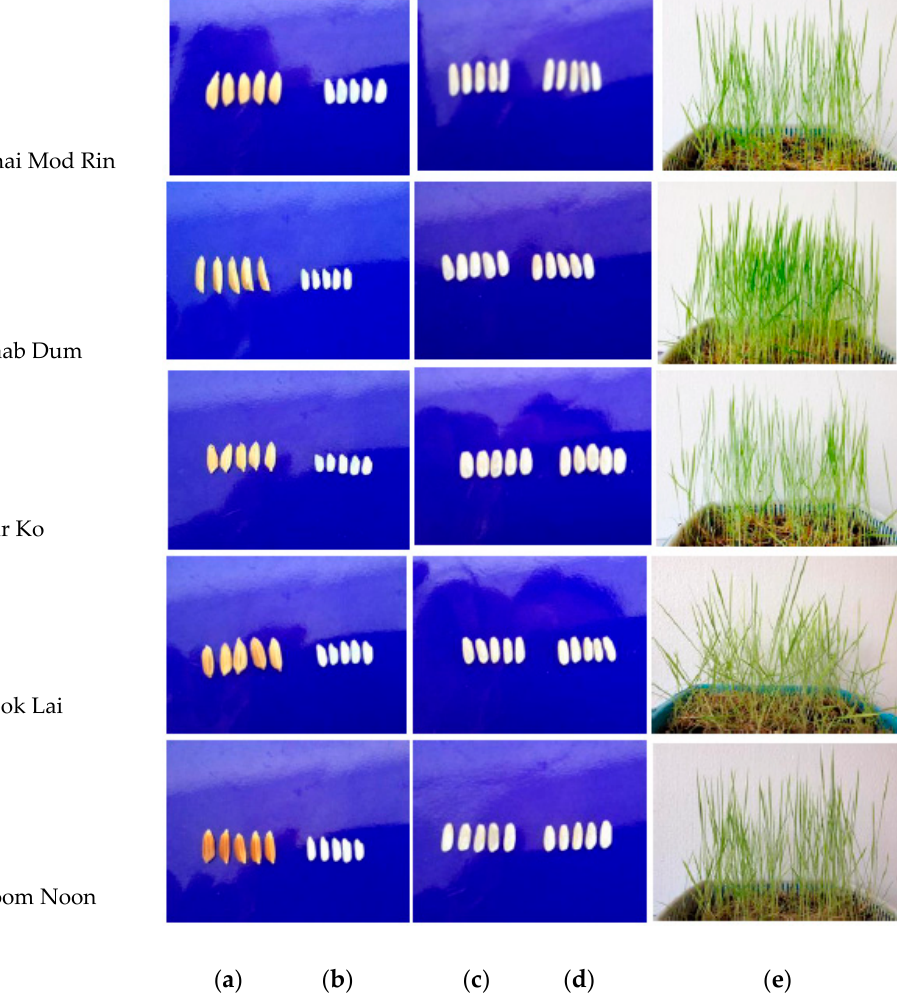
Figure 1. Appearances of paddy ( a ), white rice ( b ), brown rice ( c ), germinated brown rice ( d ), and rice grass ( e ) of southern Thai indigenous non-colored rice varieties, including Khai Mod Rin, Kaab Dum, Yar Ko, Look Lai, and Yoom Noon.